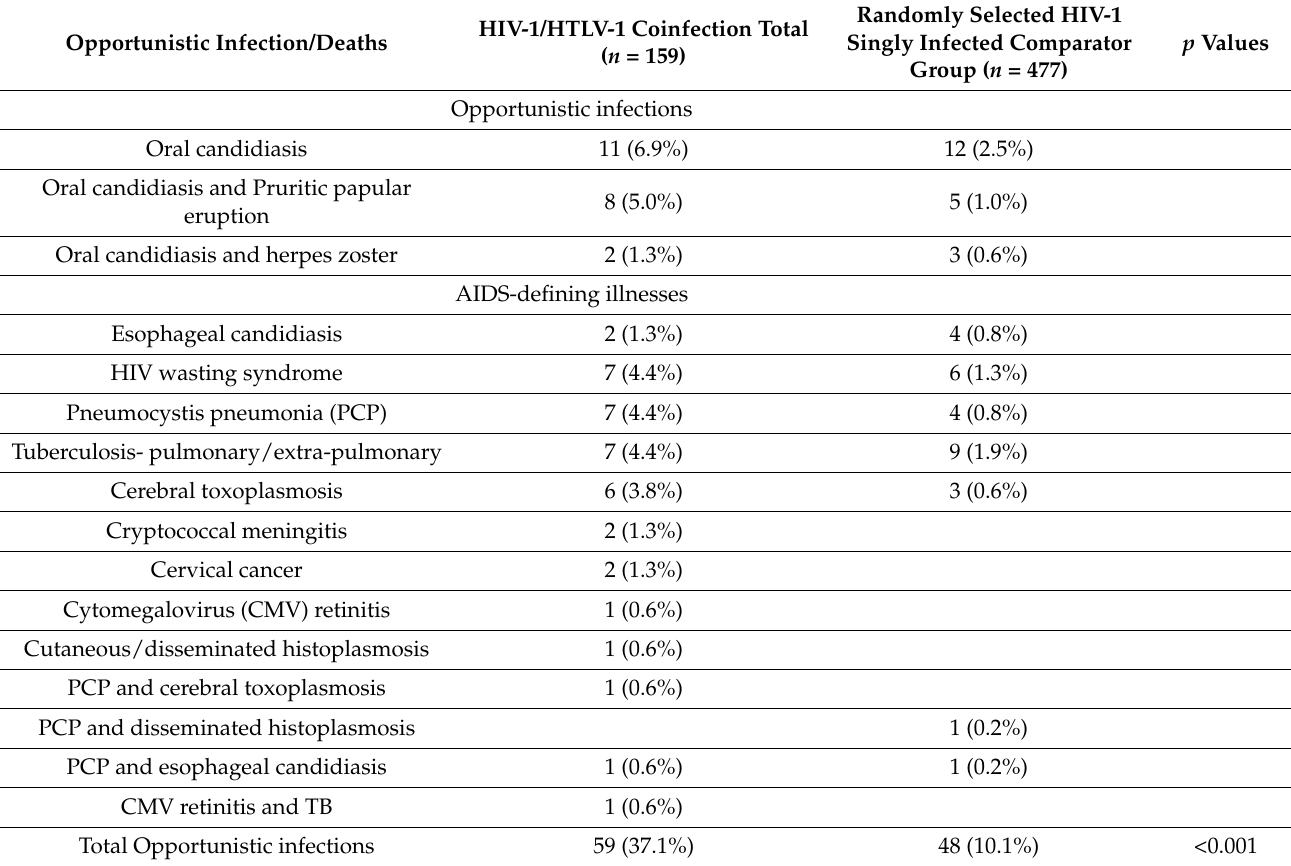
Table 2. Comparison of opportunistic infections at initial visit 2002–2018 and deaths on 31